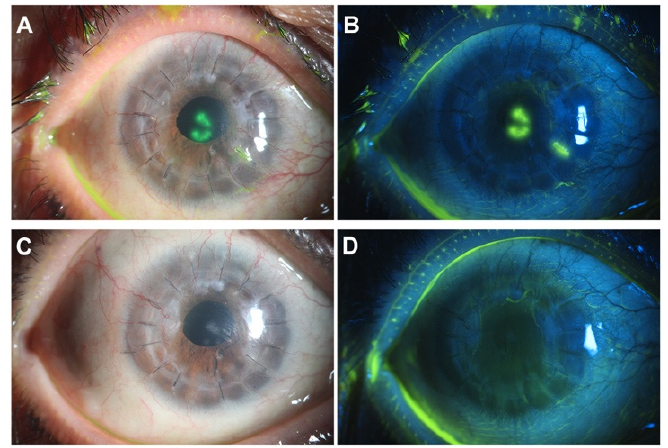
Figure 1. Reactivation of herpes simplex keratitis (HSK) following Coronavirus Disease 2019 (COVID-19) vaccination. ( A , B ) Slit-lamp examination one week postvaccination showed a typical herpes simplex viral (HSV) dendritic lesion in the corneal graft center. ( C , D ) The keratitis had resolved after a two-week antiviral treatment.